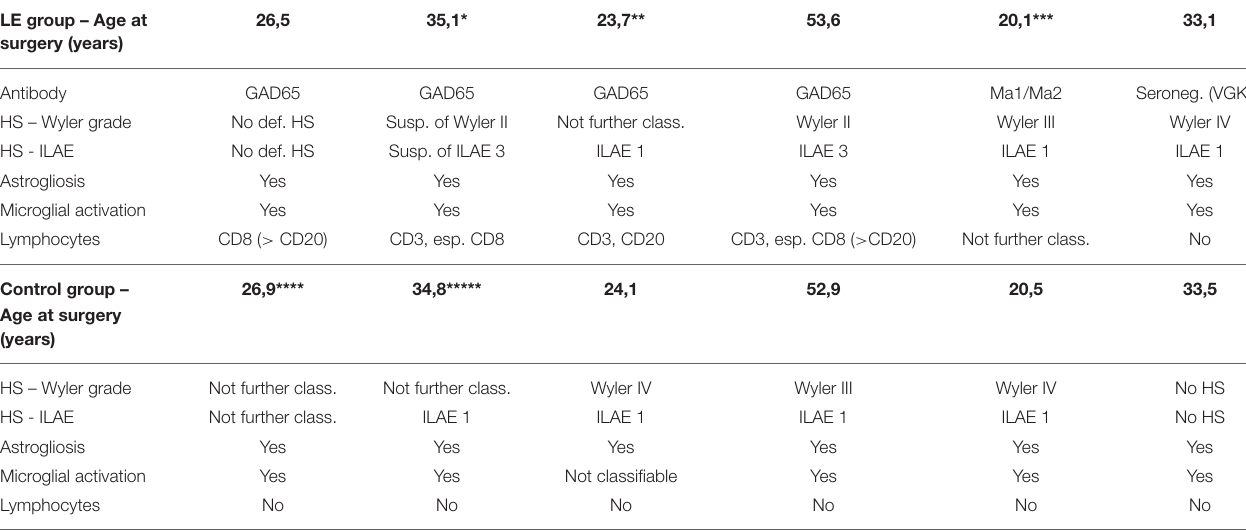
TABLE 3 | Neuropathologic findings in patients undergoing temporal lobe surgery with limbic encephalitis and in the control group. LE group – Age at surgery (years)